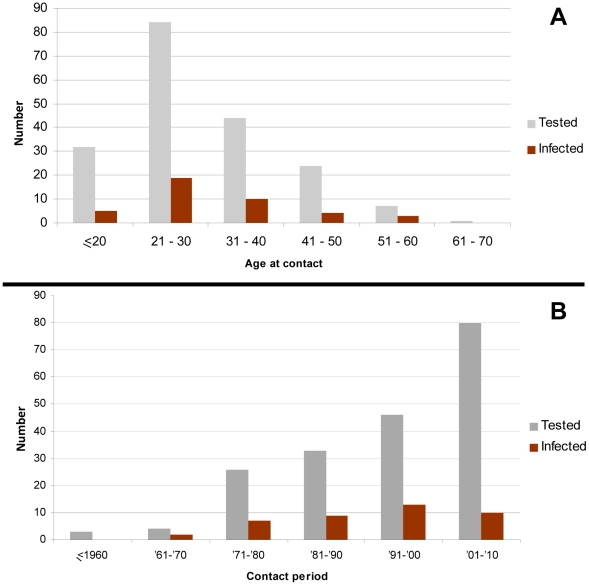
Distribution of tested and infected individuals from the “contact group”.A) According to the age at contact with NHP B) According to the time of the contact with NHP.